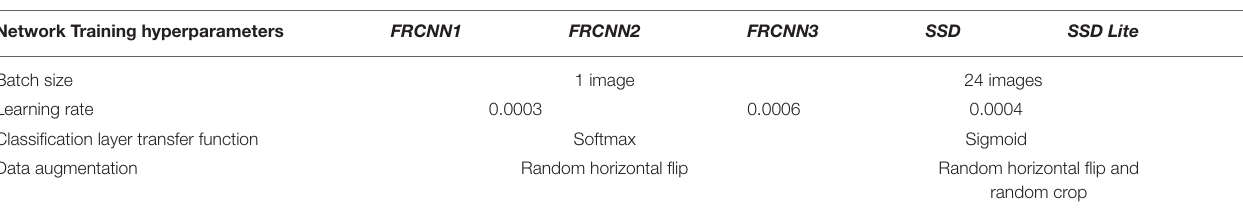
TABLE 1 | Network training